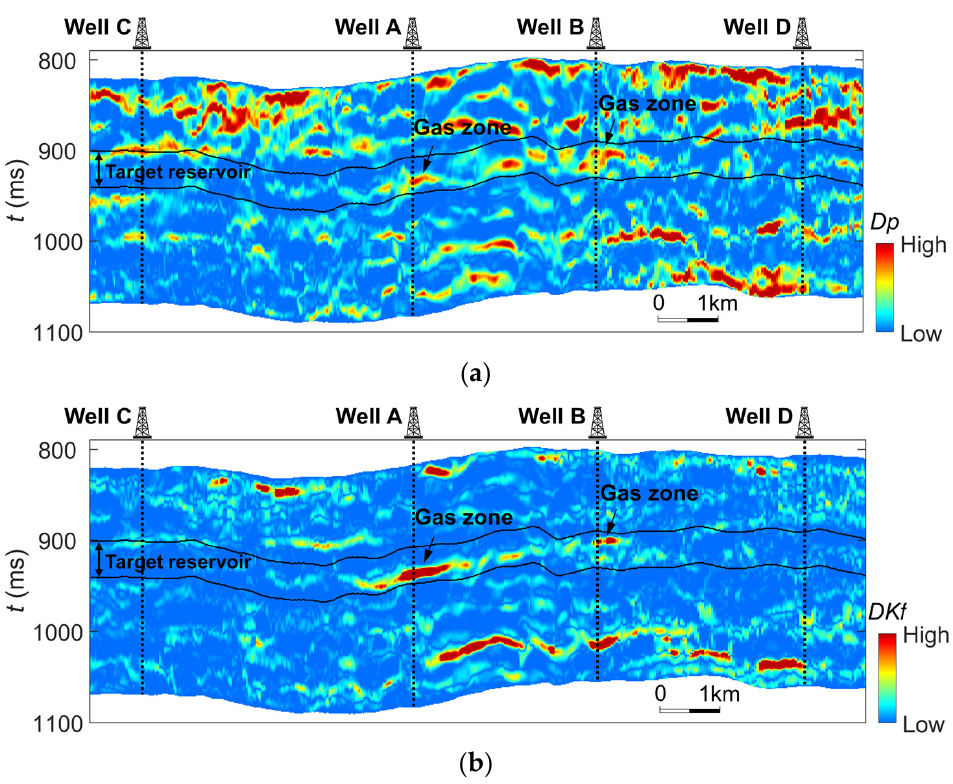
Figure 15. Profiles of inverted dispersion attributes ( a ) D P and ( b ) D Kf across wells A, B, C, and D. The two black lines indicate the target tight sandstone gas reservoir.